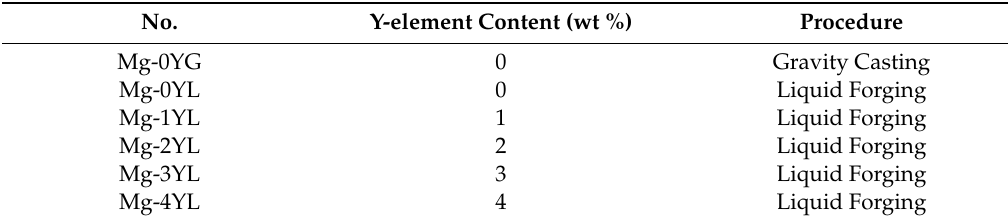
Figure 1. Schematic ( a ) and images ( b ) of the liquid forging mold; 1—upper plate, 2—punch, 3—liquid Table 3. The experimental parameters of Mg-30%Y alloy